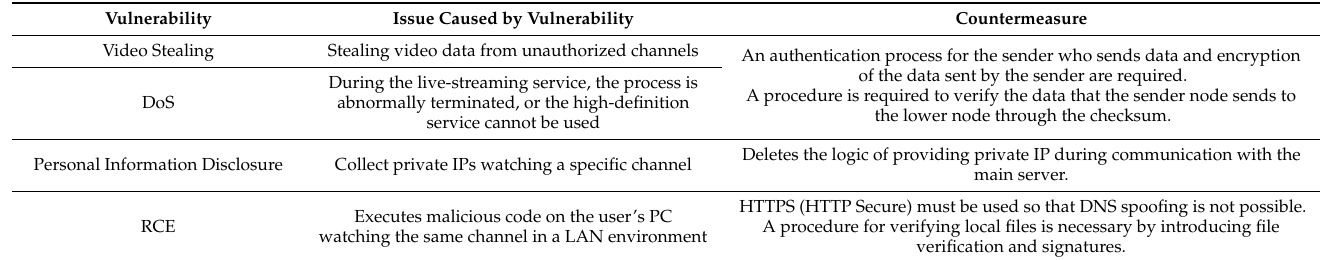
Table 7. Issue caused by vulnerability and countermeasure to